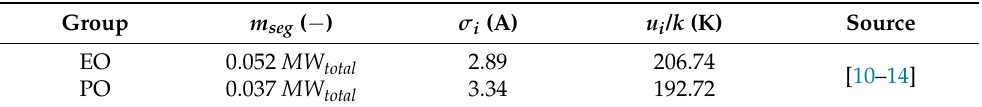
Table 1. PC-SAFT parameters of EO and PO groups for the calculation of the Poloxamers copolymers’ corresponding